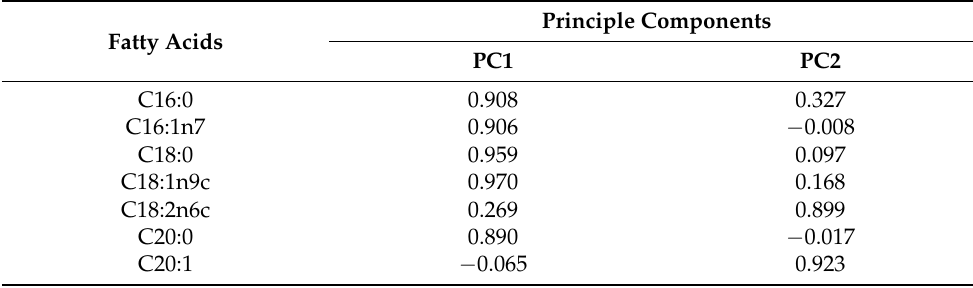
Table 7. Analysis of the fatty acid factor of fresh sweet-waxy maize by the rotating component matrix. Fatty